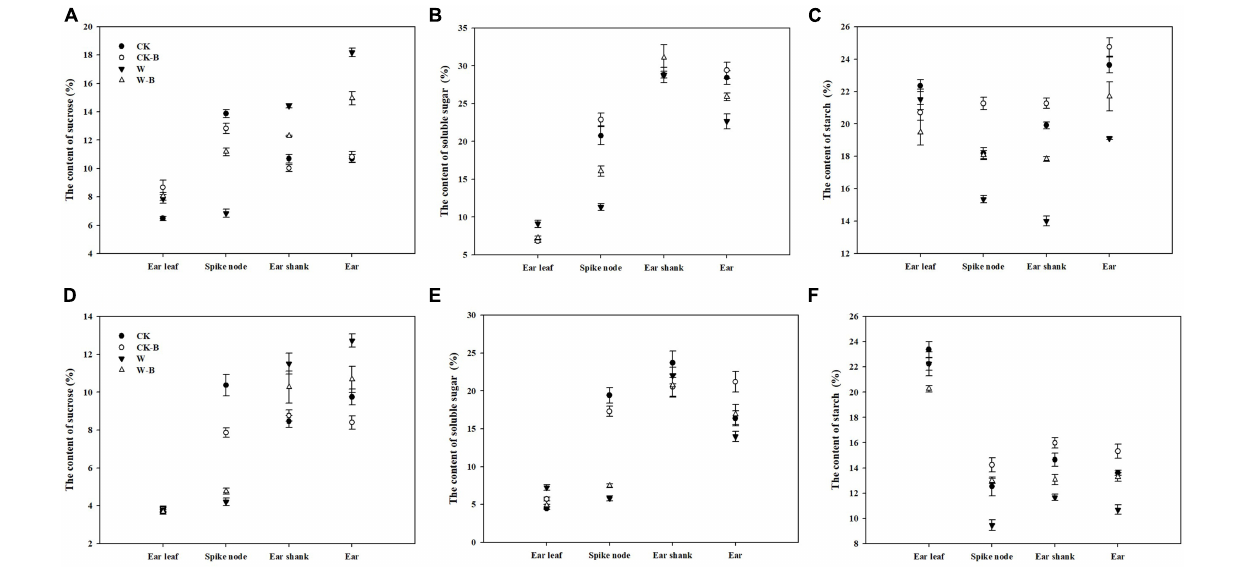
FIGURE 7 | The effects of 6-BA on the contents of sugars and starch in 2017 and 2018. (A) (2017), (C) (2018), The contents of sucrose in 2017 and 2018; (B) (2017), (D) (2018), The contents of soluble sugar in 2017 and 2018. (E) (2017), (F) (2018), The contents of starch in 2017 and 2018. CK, control, no waterlogging stress; CK-B, spraying 6-BA on non-waterlogged plants; W, waterlogging; W-B, spraying 6-BA after waterlogging.